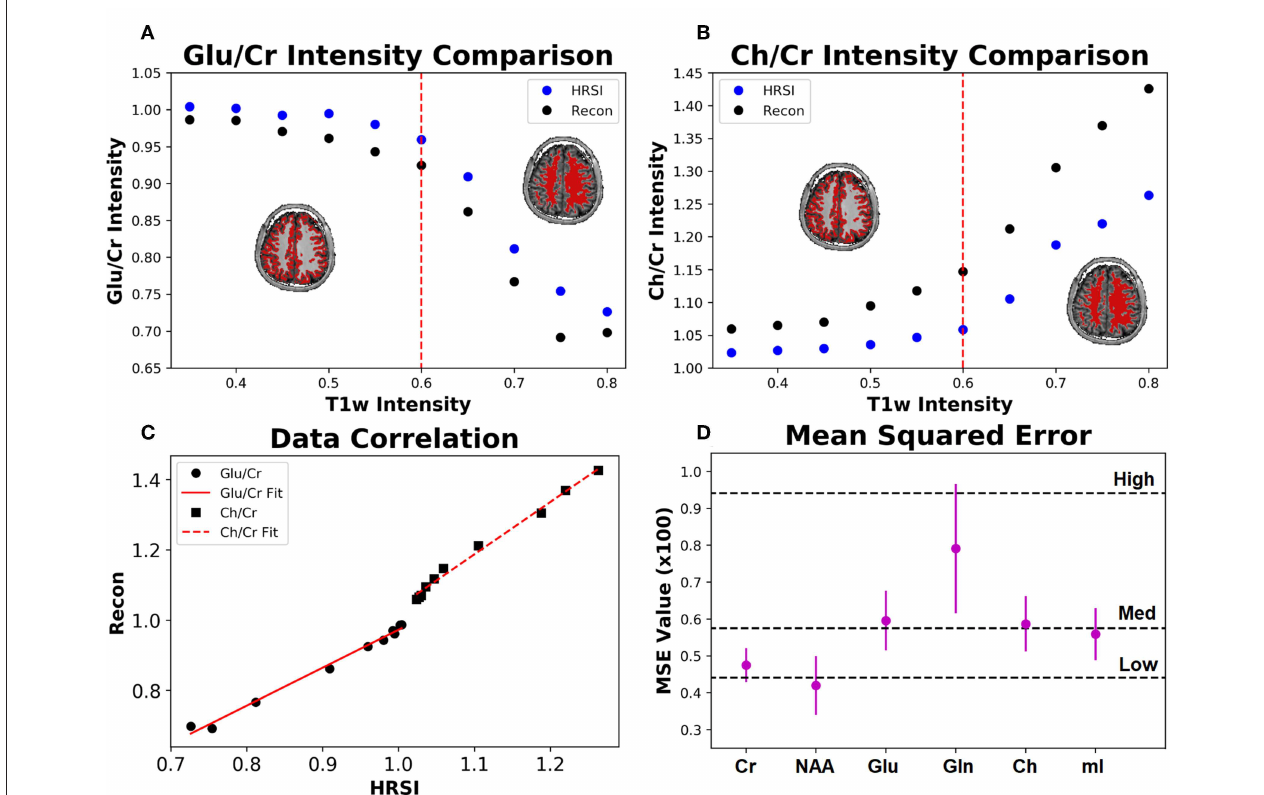
FIGURE 10 | The Glu/Cr (A) and Ch/Cr (B) signals averaged over ten subjects are shown for the experimentally acquired images (HRSI) and the images reconstructed from low resolution 32x32 images (Recon). The signals are shown as a function of the T1w intensity, which is representative of the gray and white matter content of the voxel. The red dotted line represents the point at which the gray matter content equals the white matter content in a voxel. The correlation between the HRSI and Recon values are plotted (C) with linear fits. For both Glu/Cr and Ch/Cr, the r 2 values of the fits are above 0.99. Finally, the mean squared error for the ten subjects calculated between the HRSI and Recon for each metabolite map (D) is displayed. The dotted black lines reflect the MSE from the testing set for different noise values (low, medium, and